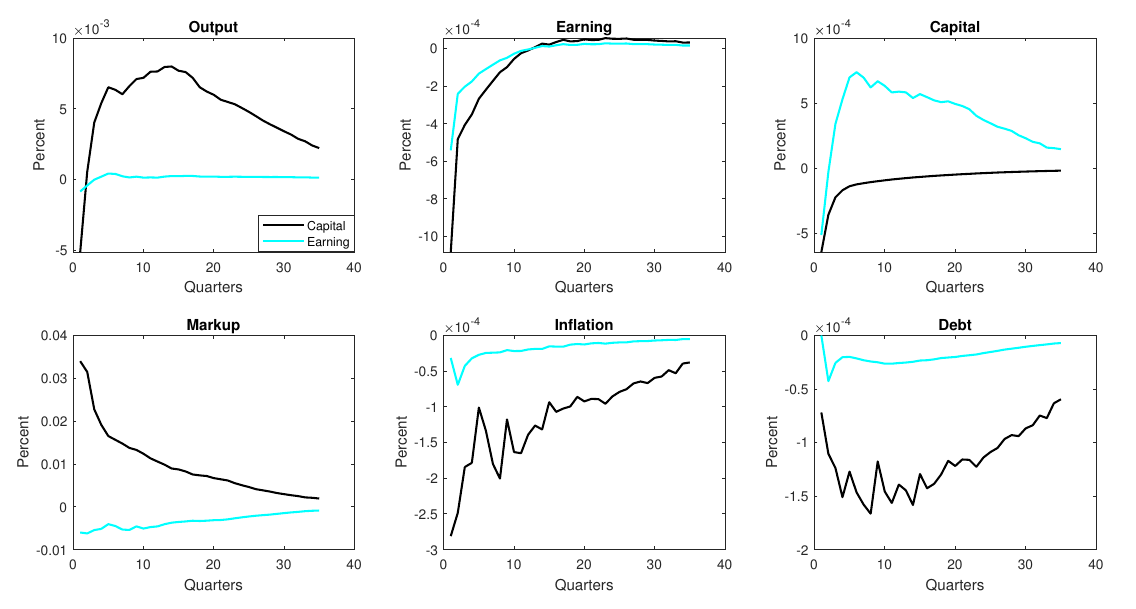
Figure A9. Effects of Demand Uncertainty Shocks in a DSGE Model with Alternative Formulations of Borrowing Constraints. Notes : Figure A9 shows the impulse responses of macroeconomic variables to a standard deviation shock in demand uncertainty, when different measurements of credit frictions are used. The black lines represent the responses of the model with asset-based constraints while the cyan colored lines are outcome of earnings-based constraints. The structural parameters to generate = 0.4 and σ = these IRFs are shown in Table 2. We calculate ρ σ σ D t D